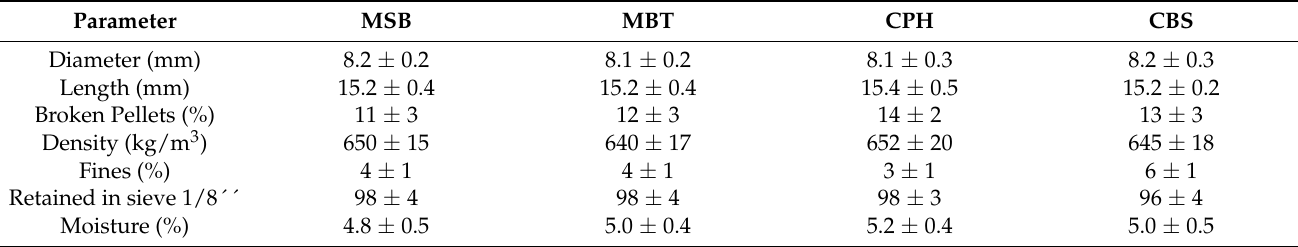
Table 6. Physical characteristics of pellets from green raw